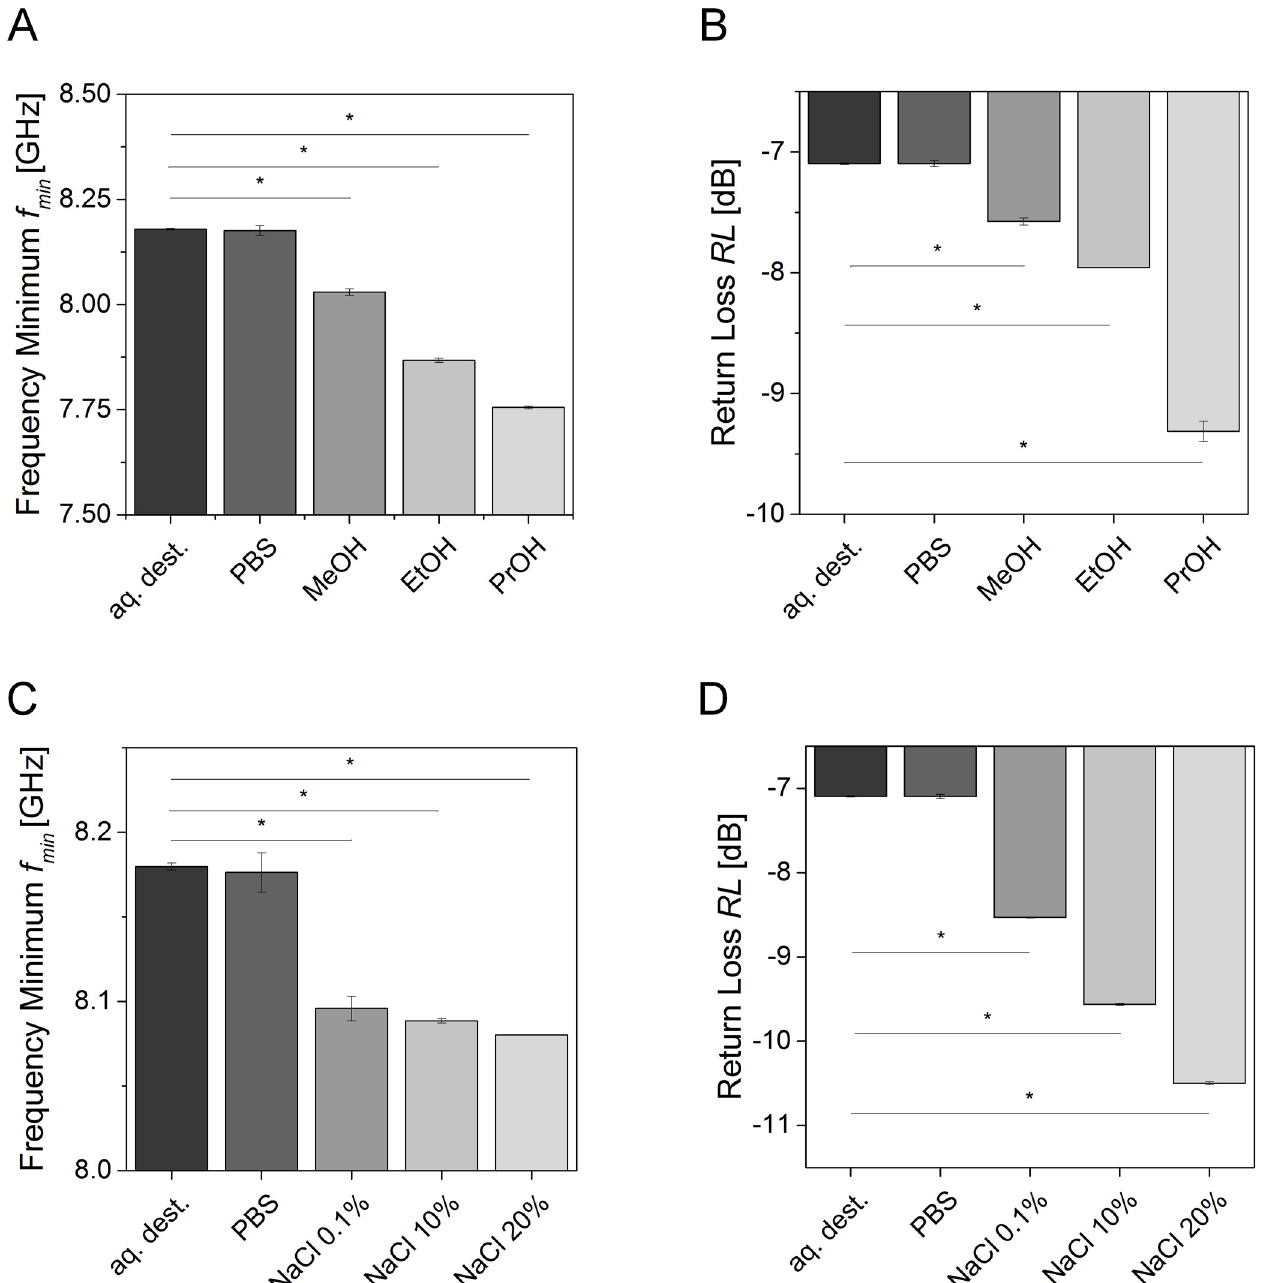
Fig 2. Retun loss (RL) and f min of fluids exhibiting different polarities and osmolalities in comparison to purified water (aq. dest.) and phosphate buffered saline (PBS). (A) f min decreased with lower polarity. Water; exhibiting the highest polarity showed the highest f min compared to methanol (MeOH), ethanol (EtOH) and propanol (PrOH) with decreasing polarities. (B) RL decreased with lower polarity from aq. dest. to PrOH. (C) f min decreased with higher osmolality from aq. dest. to sodium chloride (NaCl) solutions at concentrations ranging from 0.1 to 20%. (D) RL decreased with a higher osmolality. Bar diagrams show mean values and error bars depict standard deviation. Asterisks indicate statistical relevant differences ( p -value (cid:2) 0.5). Each group comprised three individual samples that were measured in triplicate.